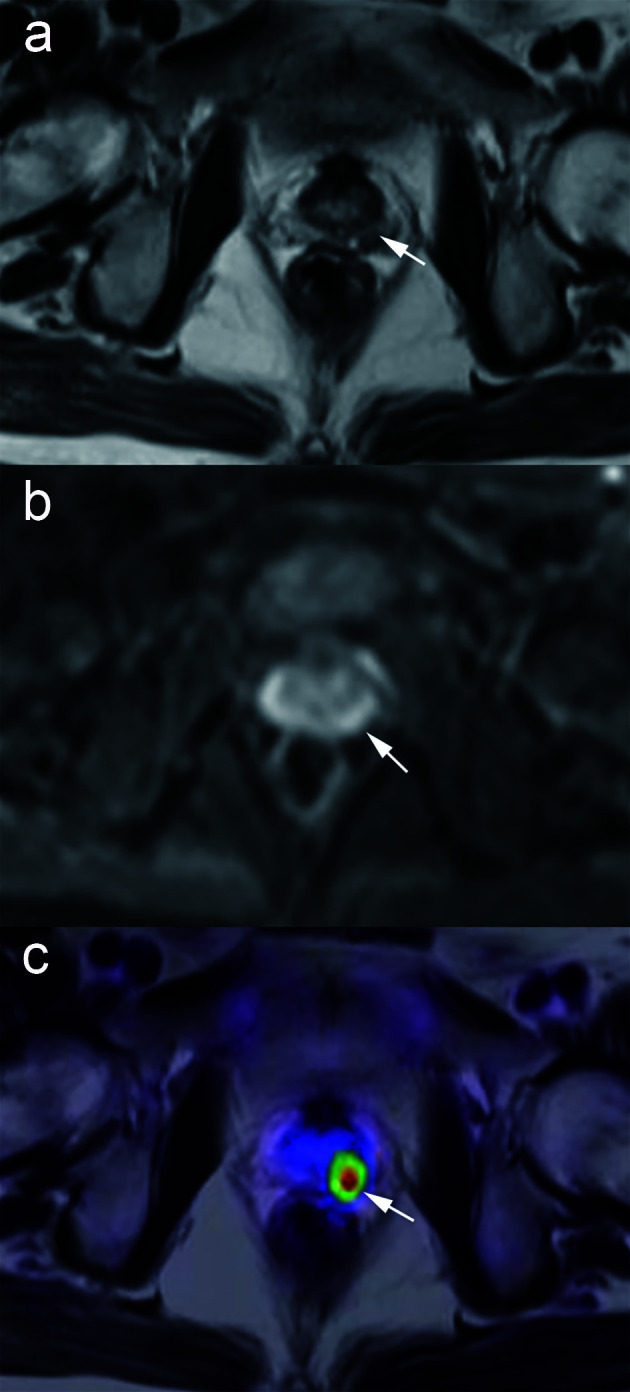
A patient treated with management change in suspected PCa. Images from a 59-year-old male with a PSA level of 7.07 ng/ml. No tumor detection within the prostate is achievable with T2-weighted or DWI sequence alone (A, B), but fused PET/MRI demonstrates tumor involvement of the left lobe (C, white arrow). The management plan was shifted from active surveillance to biopsy. The subsequent prostate biopsy confirmed Gleason 4 + 3 prostate cancer in the ipsilateral lobe.